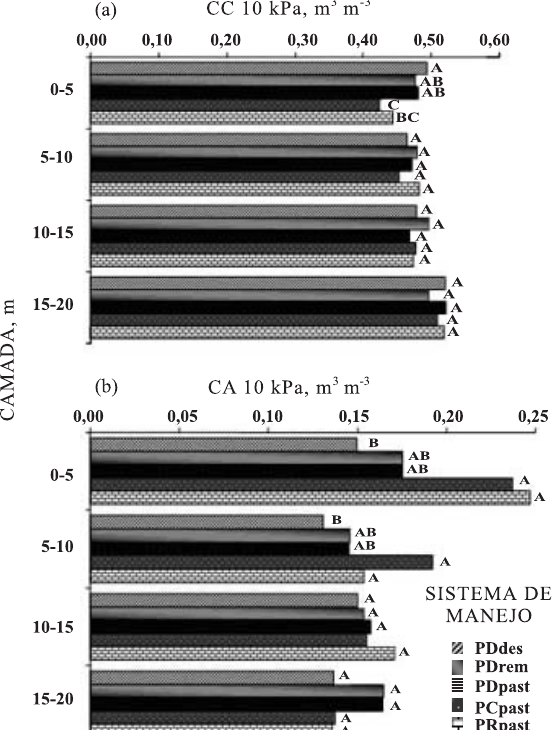
Figura 6. Capacidade de campo (CC) e capacidade de aeração (CA) a 10 kPa nos sistemas de manejo do solo e camadas, na integração agricultura- pecuária. Média de duas épocas, 88 e 190 DAS. Otacílio Costa-SC, 2003/2004. As médias dos sistemas de manejo em cada camada seguidas por letras iguais não diferem a 5 % pelo teste de